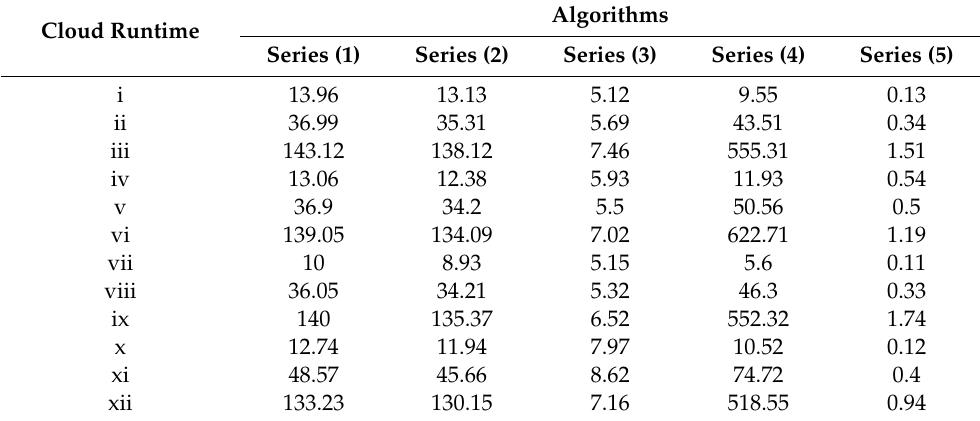
Table 2. Runtime comparative studies of existed algorithms.